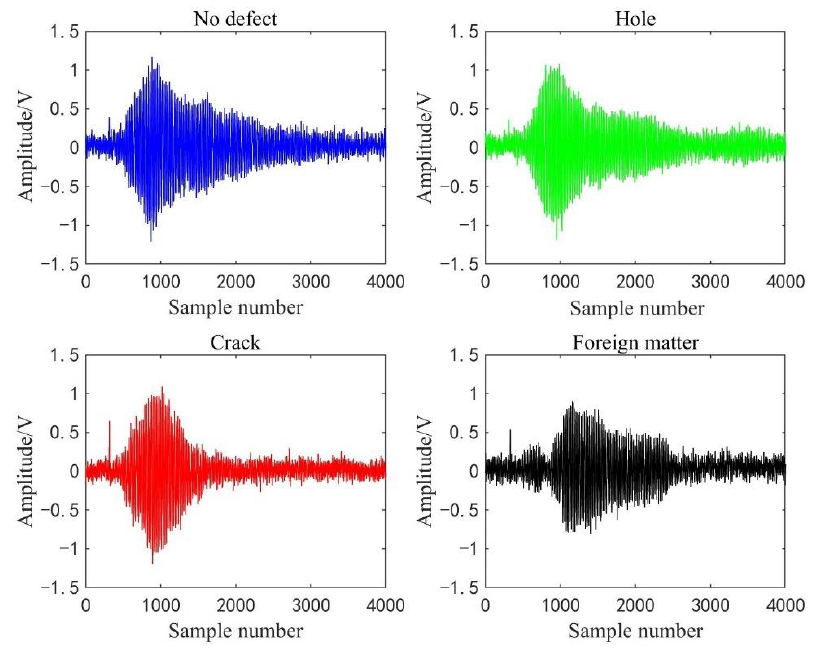
Figure 12. Four raw waveforms of detection signals.